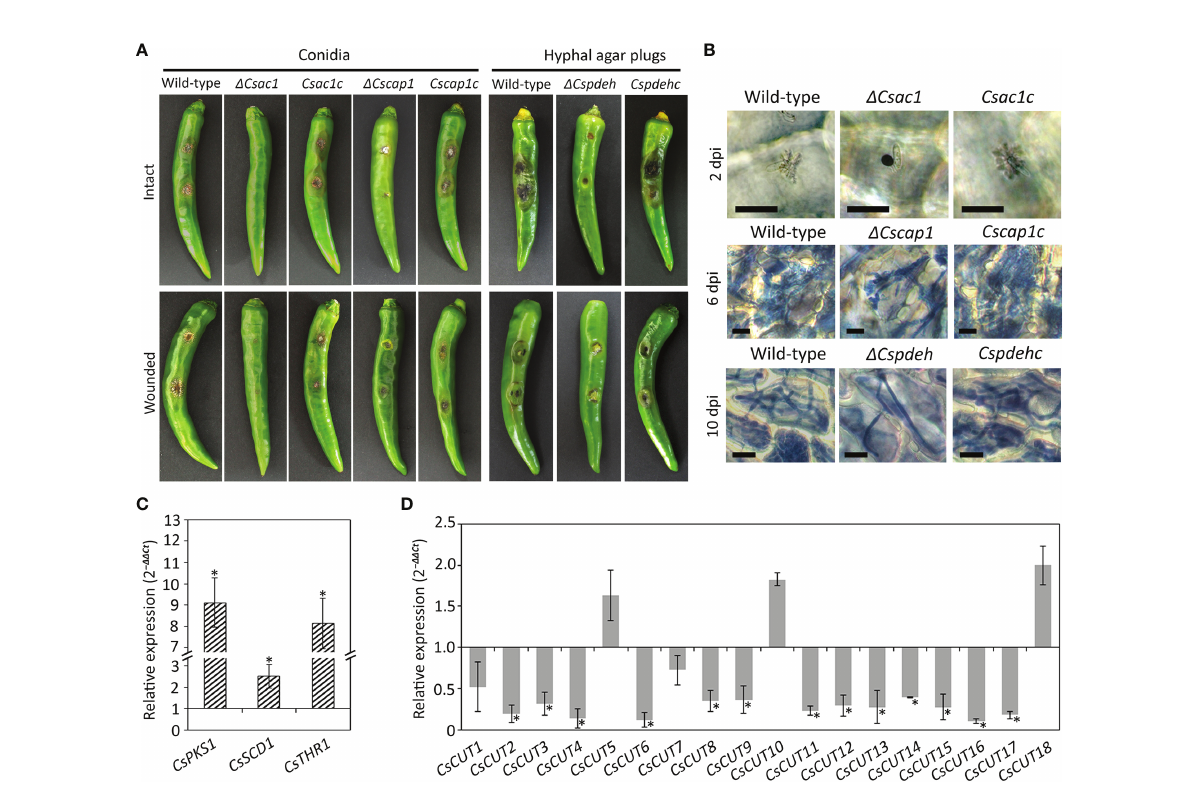
FIGURE 7 Roles of CsAc1 , CsCap1 , and CsPdeH in plant infection. (A) Photographs of anthracnose disease formation. Conidial suspensions (50 × 10 4 /mL) were dropped onto intact and wounded pepper fruits and incubated in a humid plastic box at 25°C for 9 and 6 days, respectively. Hyphal agar plugs from 3-day-old OMA cultures were inoculated onto intact and wounded pepper fruits and incubated in a humid plastic box at 25°C for 11 and 8 days, respectively. (B) Microscopic visualization of infection. Conidial suspensions (5 × 10 4 /mL) were dropped onto intact pepper fruits. Pepper fruits infected with the indicated strains showed dendroid structures in the cuticle layers. Invasive hyphae were stained blue using modi fi ed trypan blue solution. Scale bar, 20 m m. (C, D) Expression levels of melanin synthesis and cutinase genes. The C. scovillei b ‐ tubulin gene was used as a reference gene. The targeted genes in the wild-type were expressed as a relative of 1. Asterisk (*) indicates a signi fi cant difference. (C) Expression of melanin synthesis genes in D Csac1 compared to the wild-type. Melanin synthesis genes includes CsPKS1 ( CAP_001057 ), CsSCD1 ( CAP_008724 ), and CsTHR1 ( CAP_008847 ). (D) Expression of cutinase genes in pepper fruit tissues infected with D Csac1 compared to the wild-type. Information of cutinase genes is shown in Supplementary Table